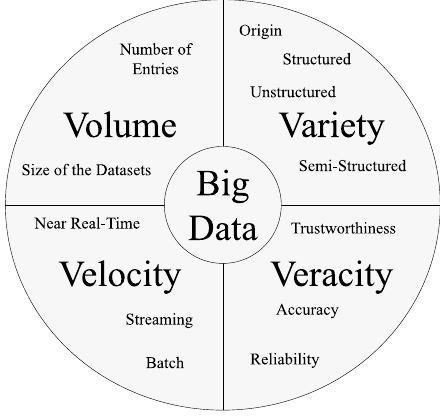
Figure 1 . The four main data characteristics of big